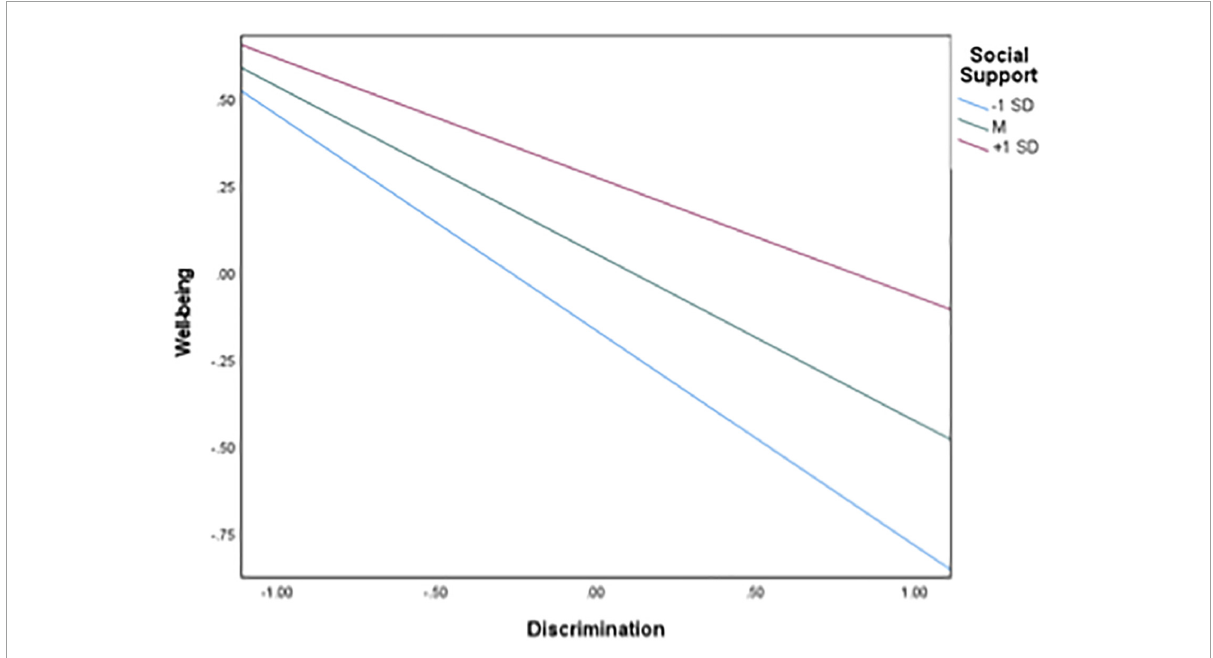
FIGURE1 Results of the simple slope